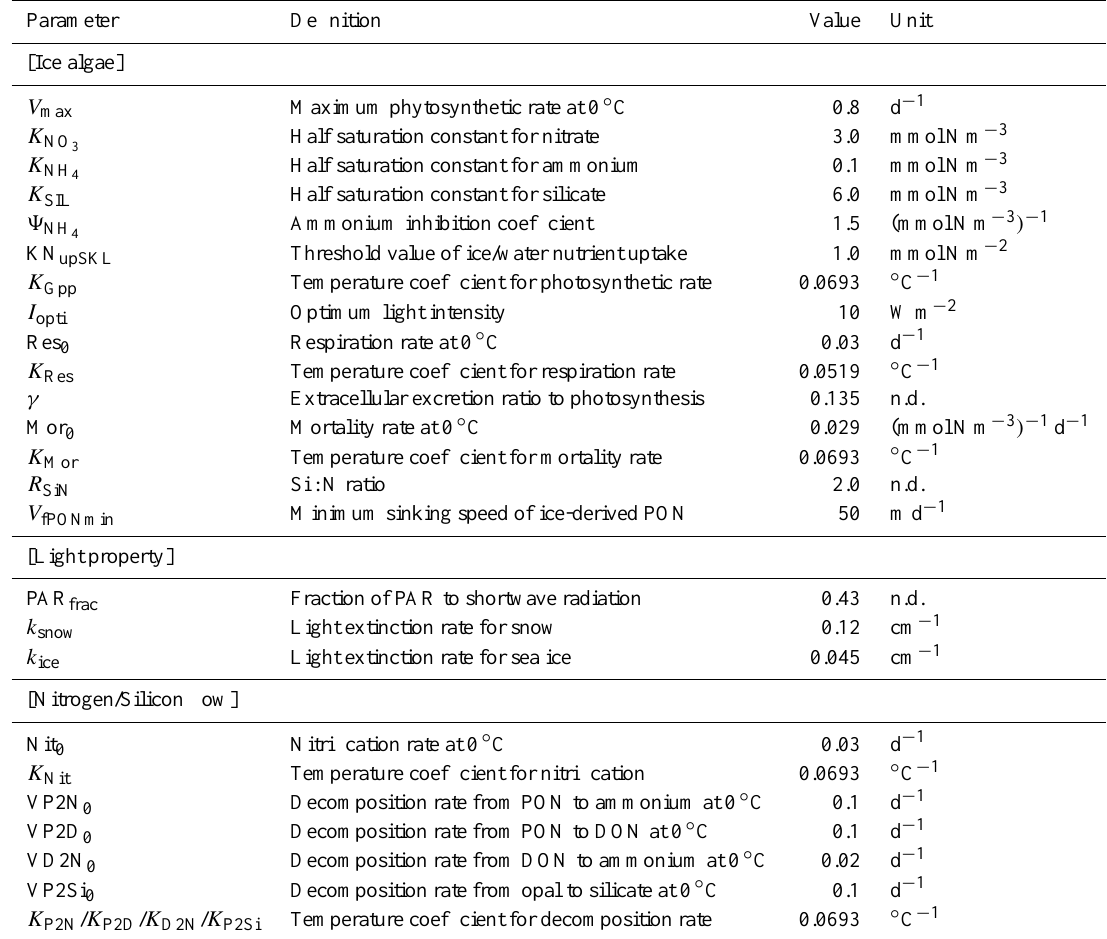
Table 1. Parameters in the sea ice ecosystem model. The values of ice algae are same as those of large phytoplankton in the original NEMURO model (Kishi et al., 2007). The PAR fraction followed Zhang et al. (2010), and the light extinction rates were derived from Aota and Ishikawa (1982). The parameter values of nitrogen and silicon flows in the skeletal layer were same as those in the water column, which were also provided by Kishi et al.